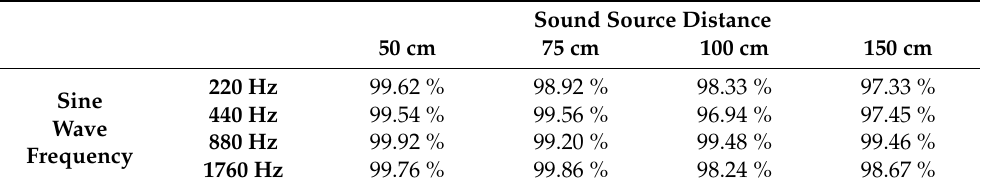
Table 1. DoA accuracy at different frequencies and